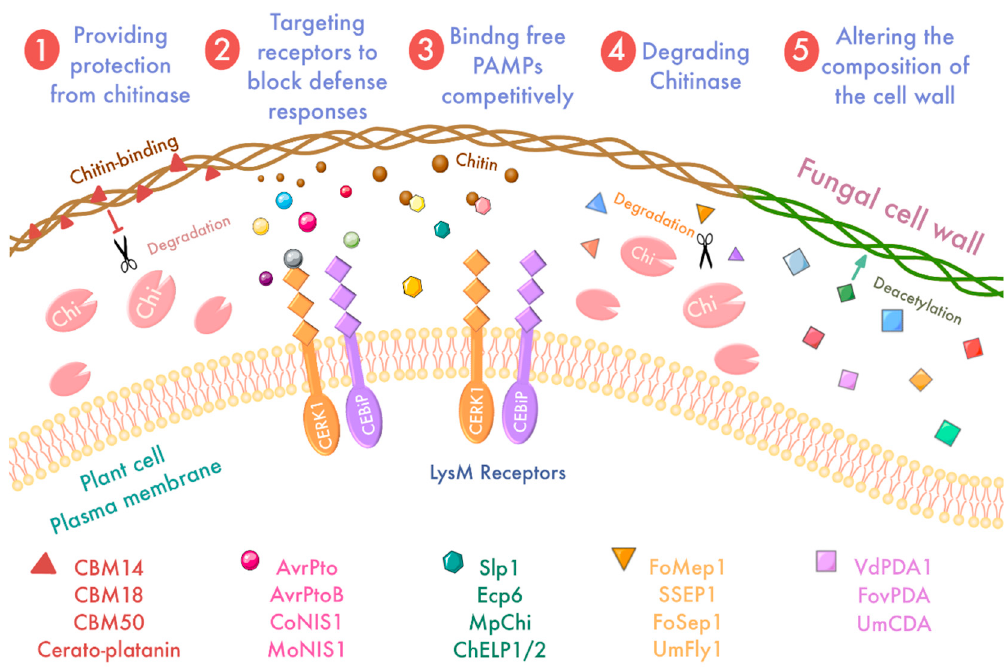
Figure 3. Inhibition of PAMP-triggered immunity by pathogens. Pathogens have developed different strategies to suppress PAMP-triggered immunity. For chitin, the main means used by pathogens are: (i) protection of the mycelium from degradation by plant chitinases, with representative effectors being the CBM family and CPP proteins; (ii) inhibition of LysM receptor recognition, with representative effectors being AvrPto, AvrPtoB, CoNIS1 and MoNIS1; (iii) isolation and masking of chitin oligosaccharides, representative effectors are Slp6, Ecp6, MpChi and ChELP1/2; (iv) targeting chitinases for degradation, representative effectors are FoMep1, SSEP1, FoSep1 and Umfly; and (v) modification and transformation of cell wall components, representative effectors are VdPDA1, FovPDA, UmCDA.